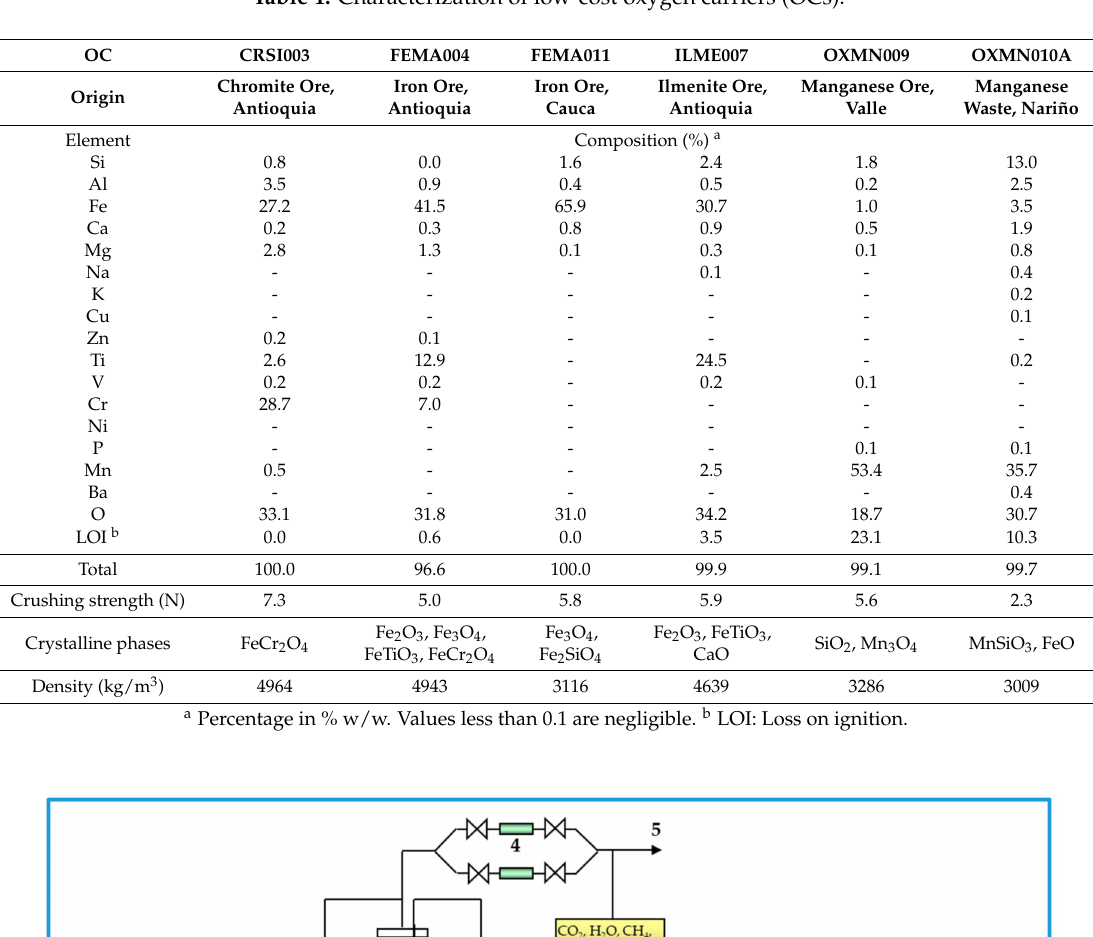
Table 1. Characterization of low-cost oxygen carriers (OCs).